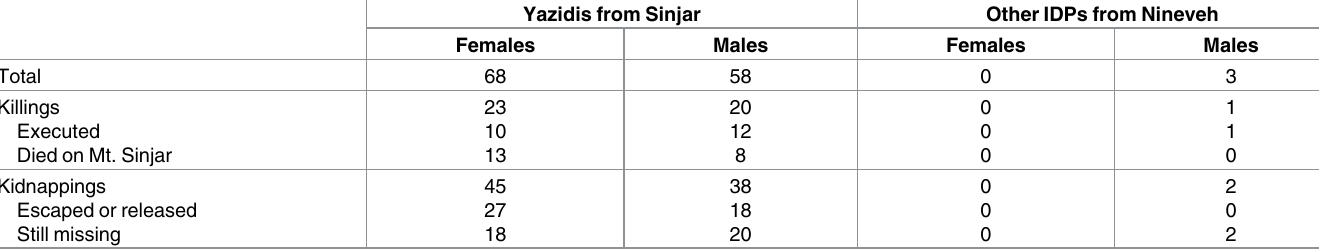
Table 3. Reported killings and kidnappings of females and males (all ages) in the sample.